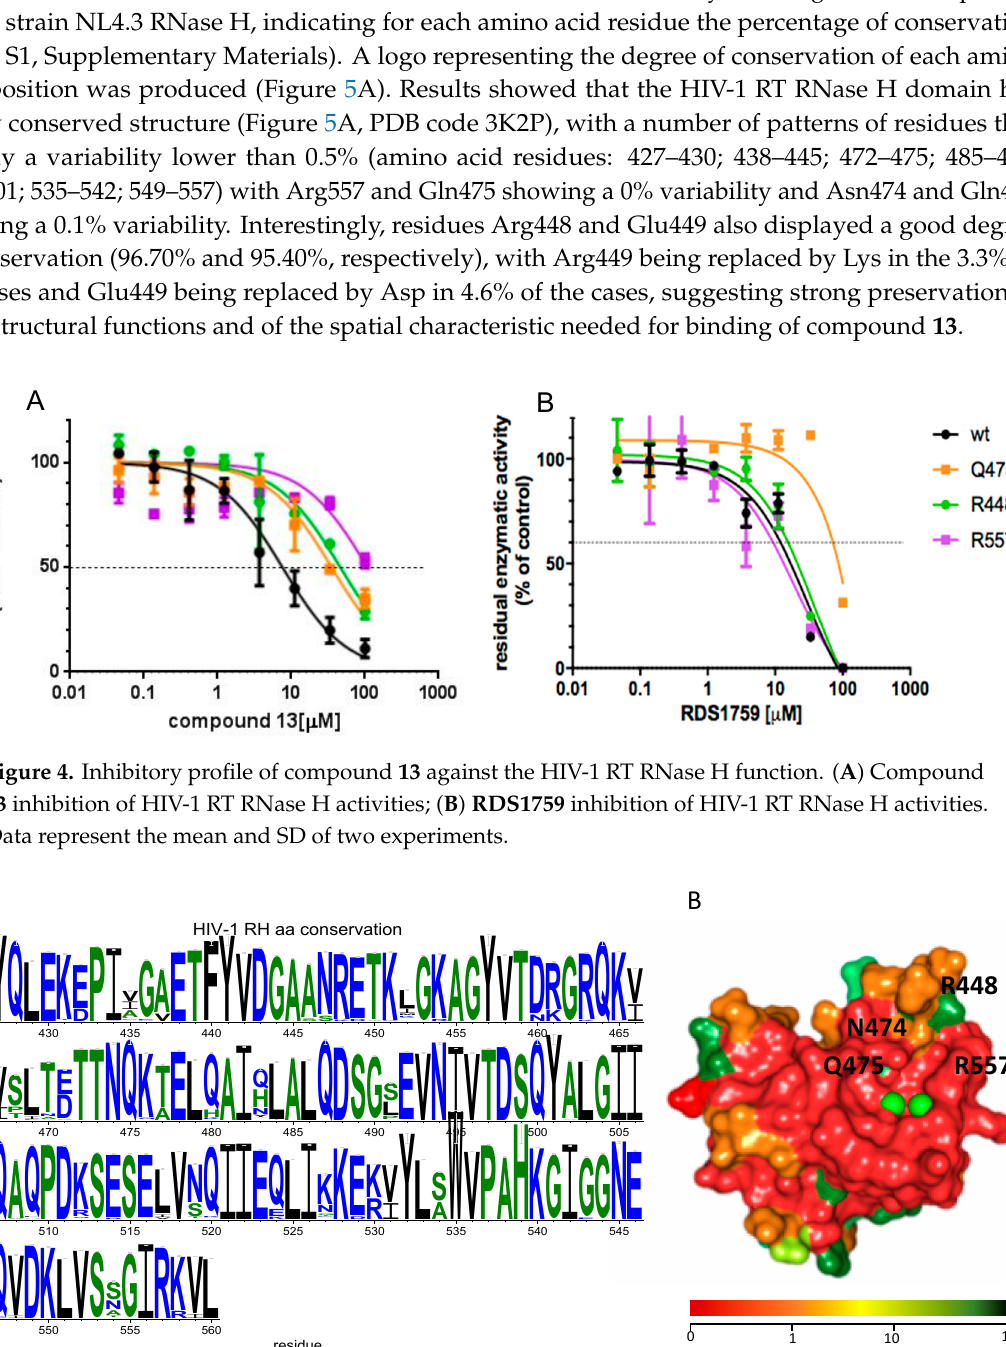
Figure 4. Inhibitory profile of compound 13 against the HIV-1 RT RNase H function. ( A ) Compound 13 inhibition of HIV-1 RT RNase H activities; ( B ) RDS1759 inhibition of HIV-1 RT RNase H activities. Data represent the mean and SD of two experiments.